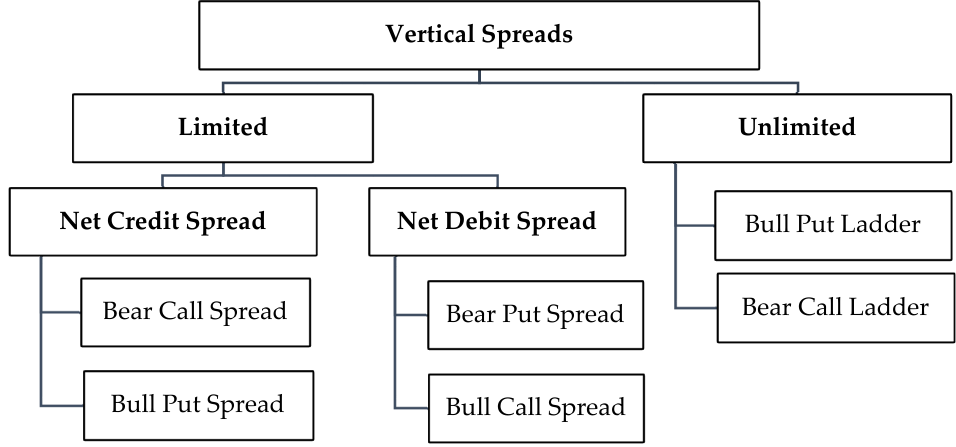
Figure 1. Classification of the vertical spread option strategies.